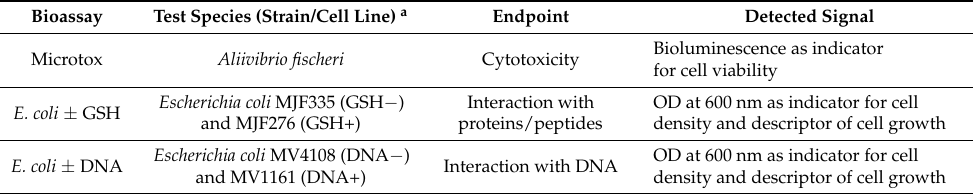
Table 1. The five endpoints of the 50 drinking water disinfection byproducts (DBPs). Bioassay Test Species (Strain/Cell Line) a Endpoint Detected Signal Bioluminescence as indicator Aliivibrio fischeri Cytotoxicity for cell viability Interaction with OD at 600 nm as indicator for cell proteins/peptides density and descriptor of cell growth OD at 600 nm as indicator for cell Interaction with DNA density and descriptor of cell